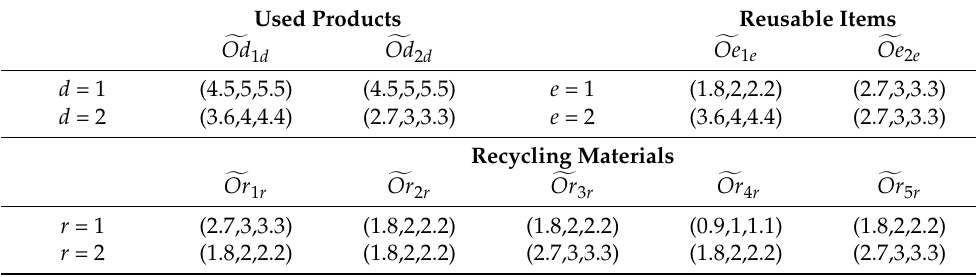
Table 9. Processing cost of dismantling, repairing, and recycling centers (us dollar).